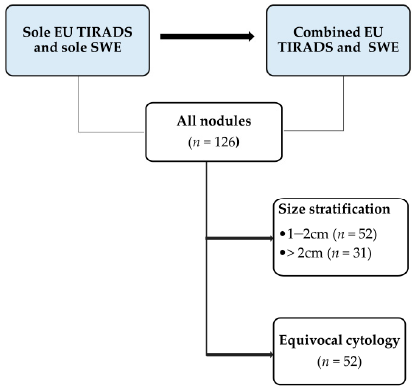
Figure 2. A stepwise illustration of the SWE analyses of the thyroid nodule